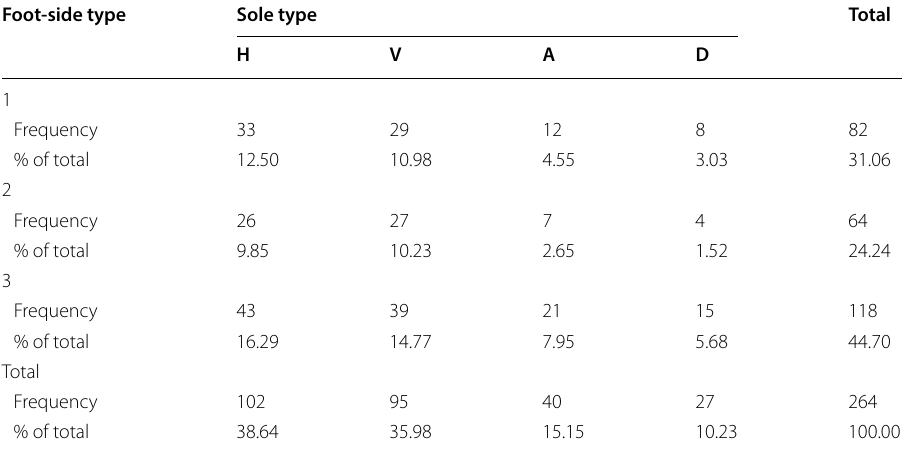
Foot-side type 1 was high forefoot and low midfoot compared to the foot length. Foot-side type 2 was low forefoot and high midfoot, and foot-side type 3 was low forefoot and low midfoot. The H-sole type has a narrow foot width, a wide heel width, and a uniform flat shape with no protruding parts, The V-sole type has foot width and toes width, wide and heel width narrow, the A-sole type has foot width and heel width, wide but toes width narrow, protruded inside, and the D-sole type has protruded